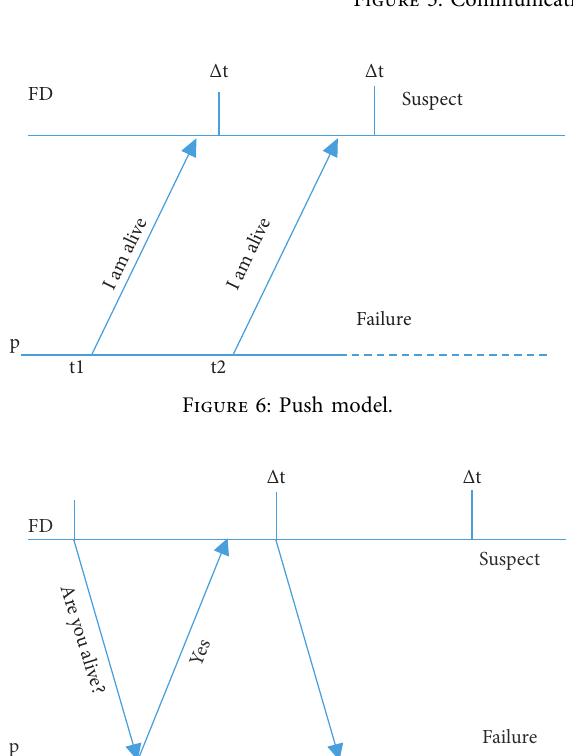
Figure 7: Pull model.